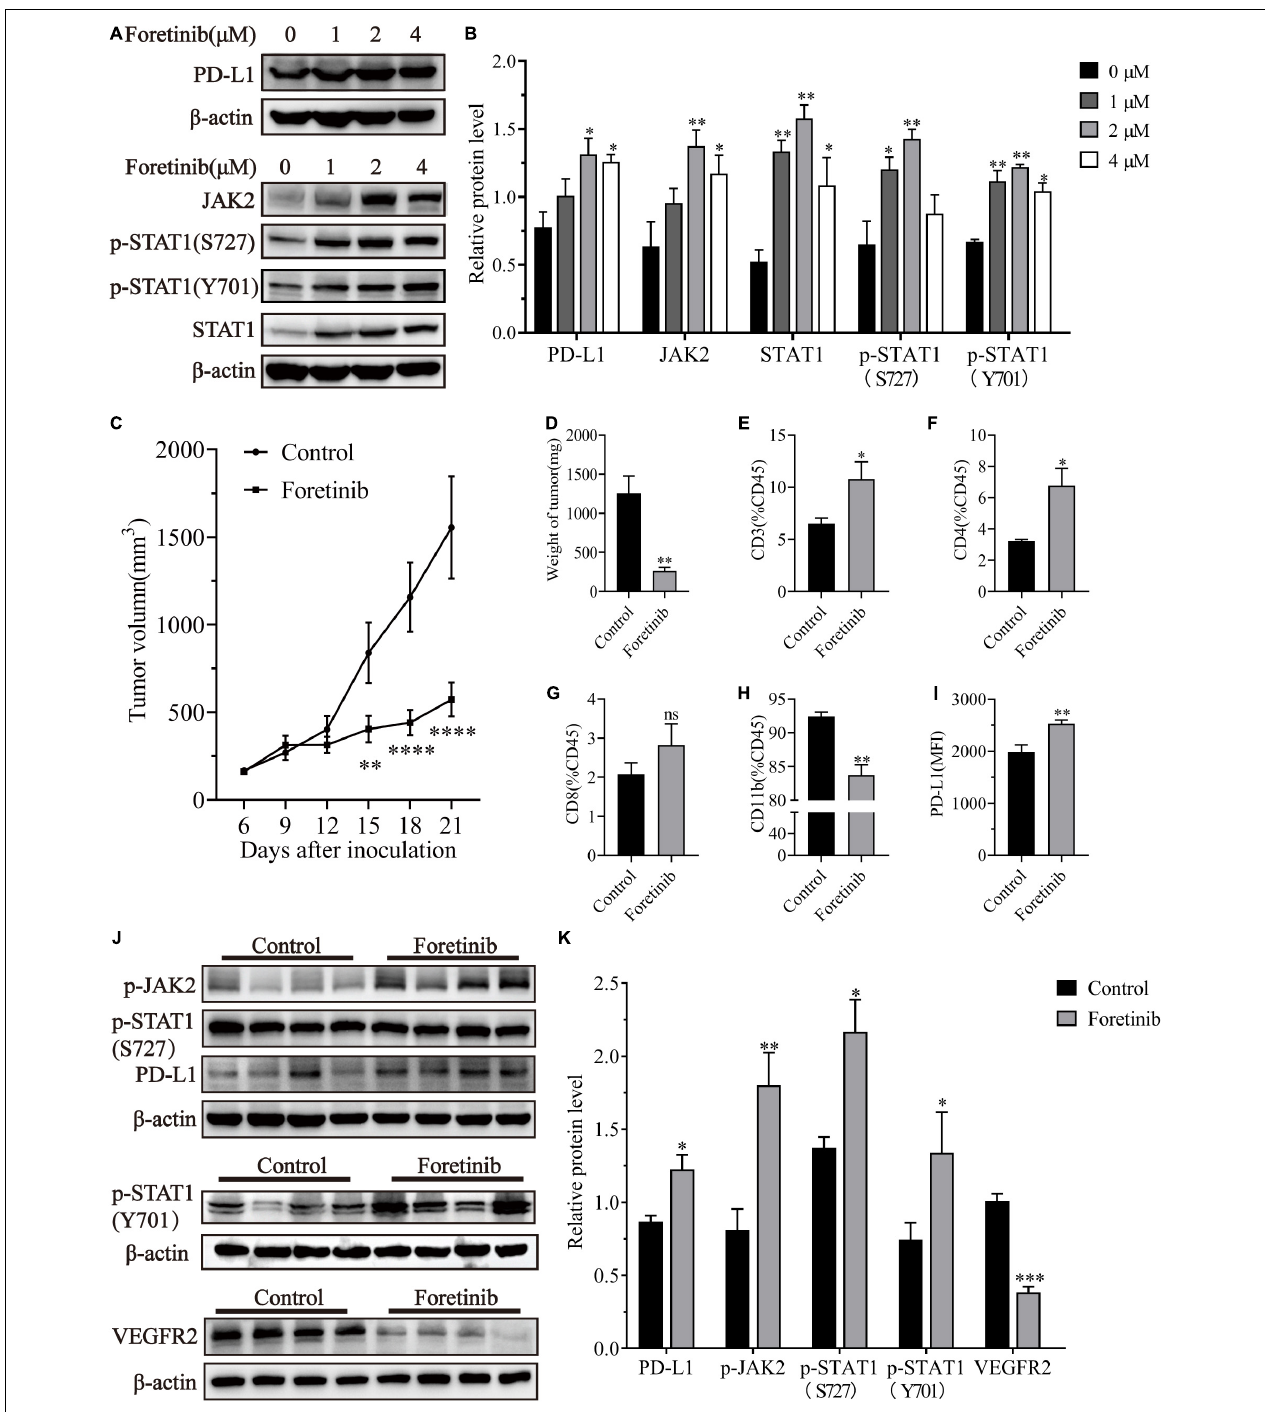
FIGURE 1 | Foretinib increased PD-L1 and enhanced the infiltration of T cells in MC38 tumors. The expression of PD-L1, JAK2, STAT1, phospho-STAT1(S727), phospho-STAT1(Y701) and β -actin was detected by Western-blotting in MC38 colon cancer cells, which were treated with different concentrations of Foretinib for 24 h. The relative protein levels were shown in figures (A,B) . MC38 cells (1 × 10 6 ) were transplanted subcutaneously into the right flank of C57BL/6 mice. Six days after transplantation (a tumor volume nearly of 100 mm 3 ), the mice were randomly allocated to either the control or treatment groups. Drugs were administered as described in the “Materials and Methods” section and the tumor volumes were measured every 3 days (C) , six mice were allocated per group ( n = 6). After the treatment was completed, the tumors were harvested and weighed (D) and the infiltration of CD3 + (E) , CD4 + (F) , CD8 + (G) , and CD11b + (H) cells was determined and the mean fluorescence intensity (MFI) of PD-L1 (I) in the tumors was determined by FCM. The relative protein levels in the tumor tissue for phospho-JAK2, STAT1, phospho-STAT1(S727), phospho-STAT1(Y701), PD-L1, VEGFR2, and β -actin were determined using Western-blotting (J,K) ( n = 4 mice). The data was presented using the mean ± SEM where applicable, * ( P ≤ 0.05), ** ( P ≤ 0.01), *** ( P < 0.001), **** ( P < 0.0001) and ns (no statistical significance, P ≥ 0.05).